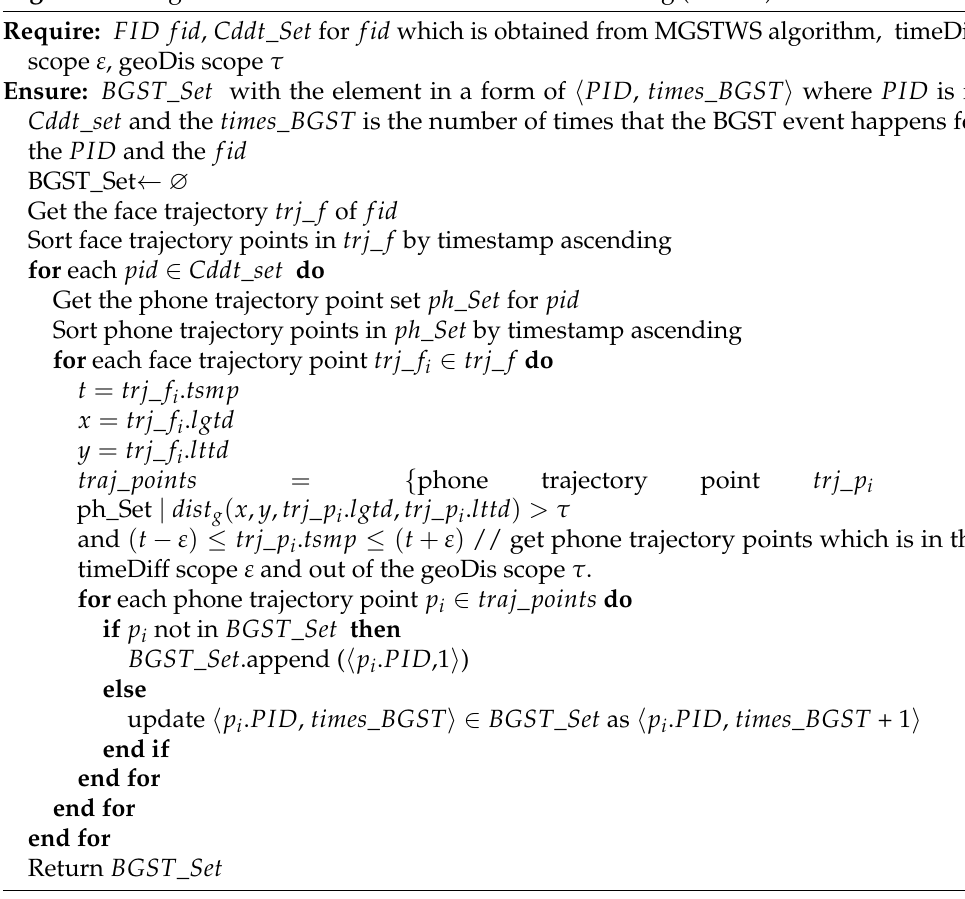
Algorithm 2 Big GeoDis and Small TimeDiff Event Searching